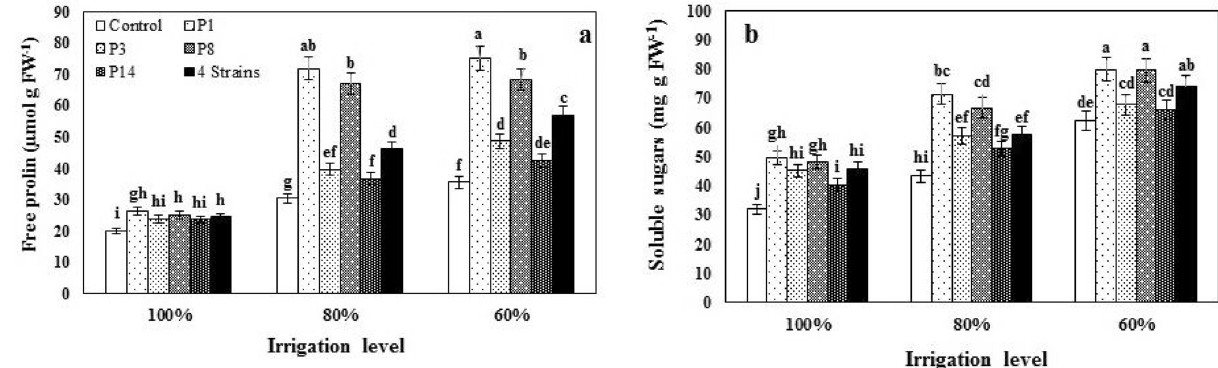
Figure 5. The effect of inoculation with different strains of Pseudomonas fluorescens (P 1 , P 3 , P 8 , P 14 and 4 Strains: combination of four strains) under three irrigation levels on free proline and total soluble sugars. Different letters on mean ± standard error bars showed significant difference (LSD at p ≤ 0.05).